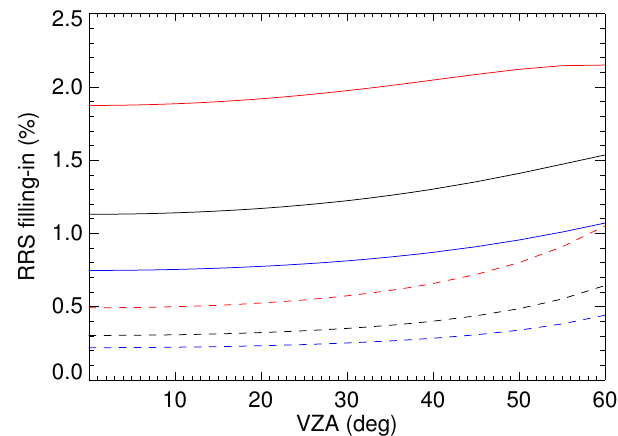
Fig. 5. Maximum percentage filling-in due to RRS within 760–762 nm, as a function of VZA for SZA = 45 ◦ (dashed line) and 70 ◦ (solid line) and relative azimuth angle of 90 ◦ . Red: FWHM 0.1 nm; Black: FWHM 0.5 nm; Blue: FWHM = 1.0 nm.